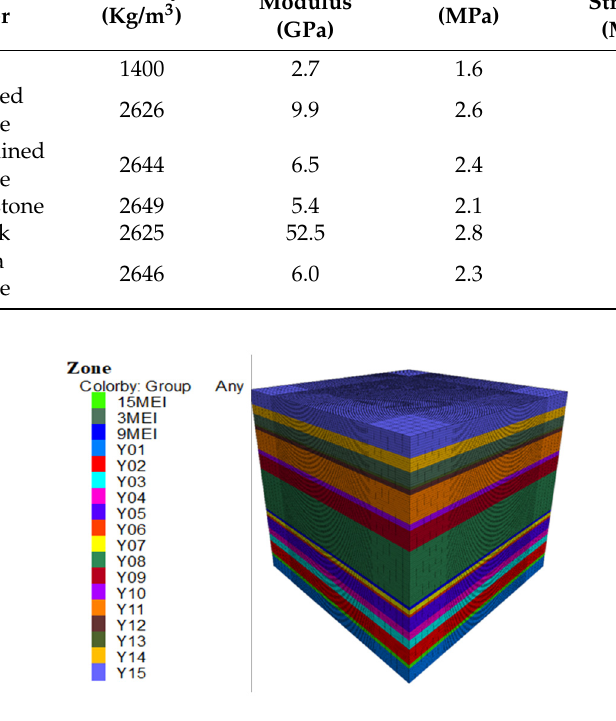
Figure 7. Numerical calculation model.